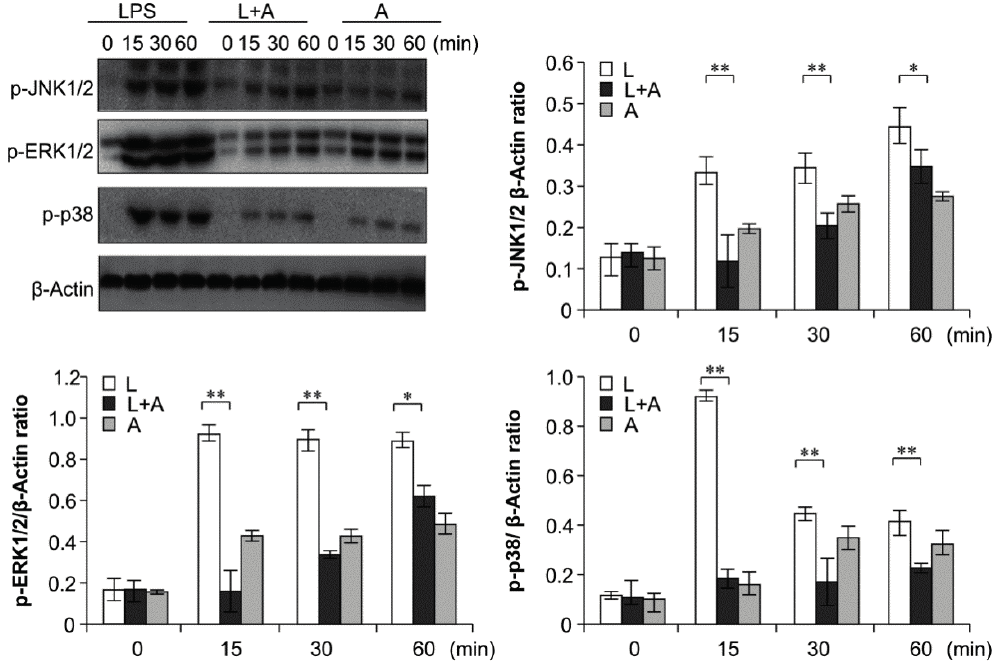
Figure 7. Western blot analysis for inhibition of MAPK activation by humanized anti-TLR4 antibody Fab. Cells were pretreated with humanized anti-TLR4 antibody for 2 h and further incubated in presence or absence of LPS (1 µg/mL). After immunoblotting, the phosphorylation levels of ERK1/2, JNK1/2, p38 were identified using phosphor-specific antibodies. β -Actin was used to ensure equal loading. L: LPS, A: humanized anti-TLR4 antibody. Data are shown as mean ± SD ( n = 3, * p < 0.05, ** p < 0.01 versus LPS